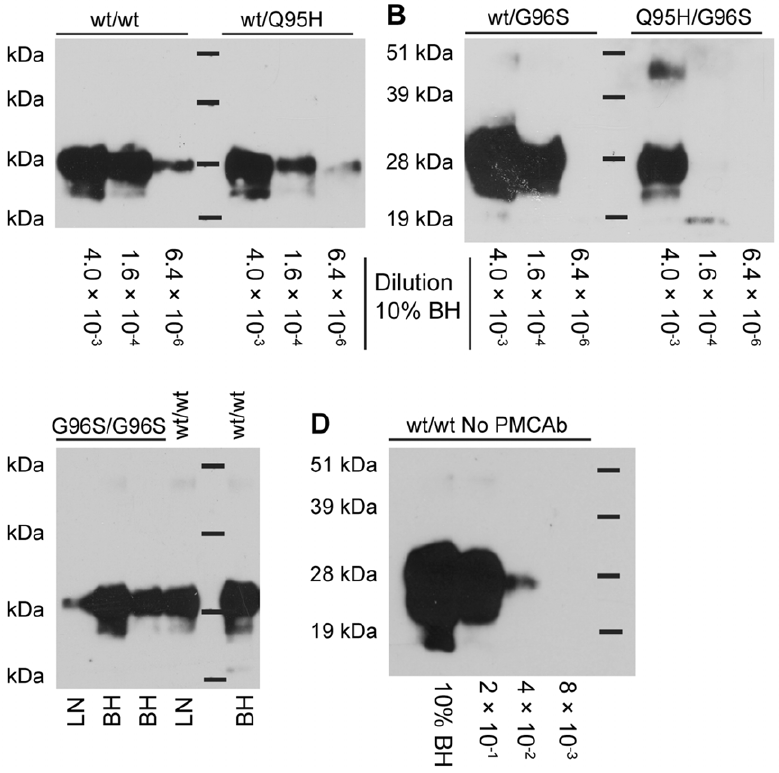
Figure 6. PMCAb amplifies PrP CWD from white-tailed deer with allelic variations and from non-CNS tissues. Brain homogenates (BH; 10% w/v) from CWD-positive deer with allelic variations of Prnp were tested for their ability to seed PMCAb. CWD-positive 10% BH from (A) wt/wt or wt/95H deer and (B) wt/96S or 95H/96S white-tailed deer were serially diluted in normal BH (NBH) from Tg(CerPrP)1536 + / 2 mice, and 10 m L of the 25-, 625- and 1.6 6 10 4 -fold dilutions from each were used to seed 90 m L fresh NBH and subjected to one 96-cycle PMCAb round. (C) For testing the homozygous 96S allelic variant, retropharyngeal lymph nodes (LN) or BH from two separate hunter-harvested CWD-positive deer were used to seed NBH for PMCAb. As controls, homogenates of lymph nodes from a hunter-harvested CWD-positive wt/wt deer or orally inoculated wt/wt CWD clinically affected deer was used to seed a 96-cycle round of PMCAb. (D) Immunoblotting three five-fold dilutions of 10% BH from the end-stage wt/ wt deer used for these studies after proteinase K digestion demonstrates that the PrP CWD concentrations used in the PMCAb reactions (Fig. 6A) were not detectable without amplification.